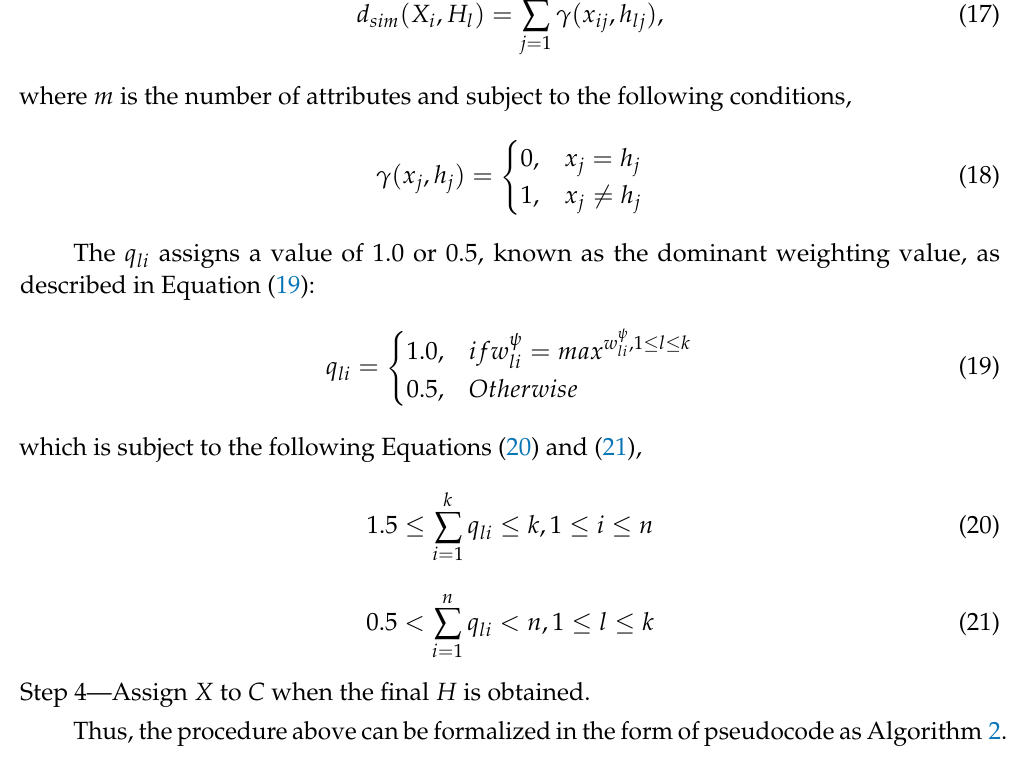
Algorithm 2 k-AMH ( X , k , ψ )